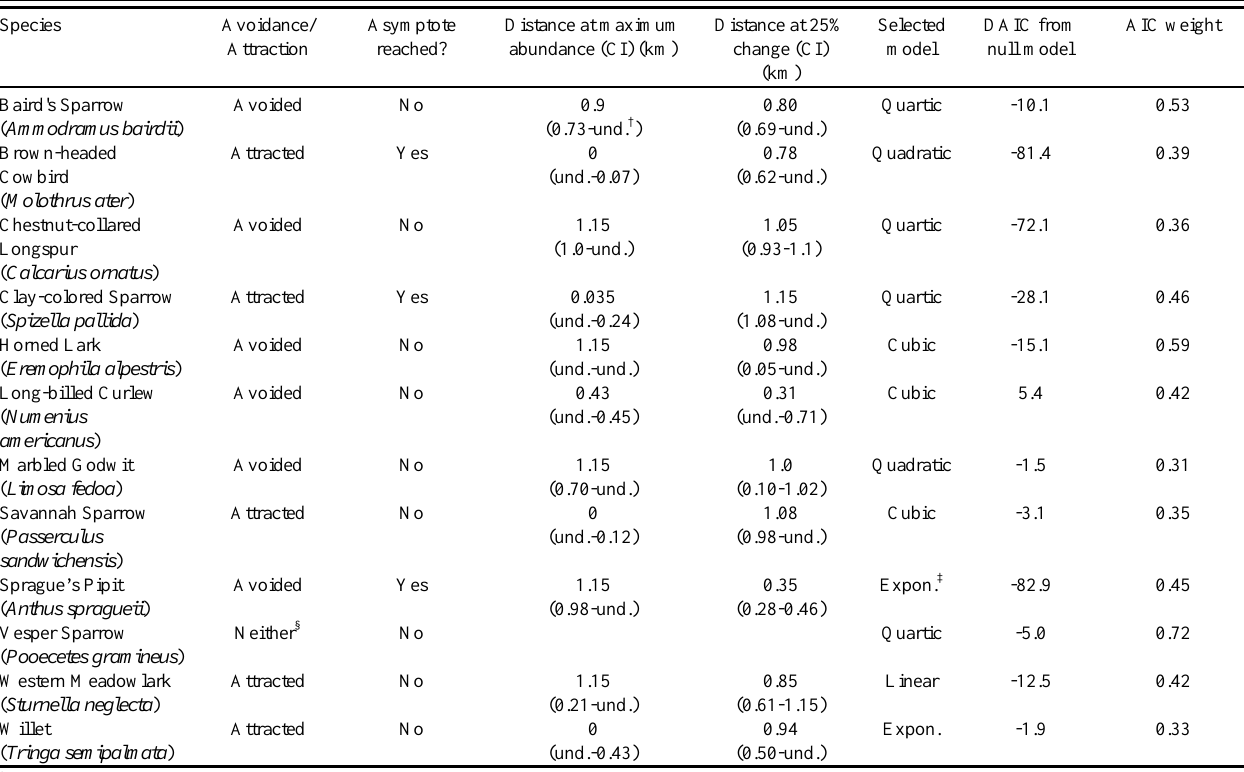
Table 4 . Effect of distance to wetlands on 12 bird species in Alberta, Canada, 2000-2002.